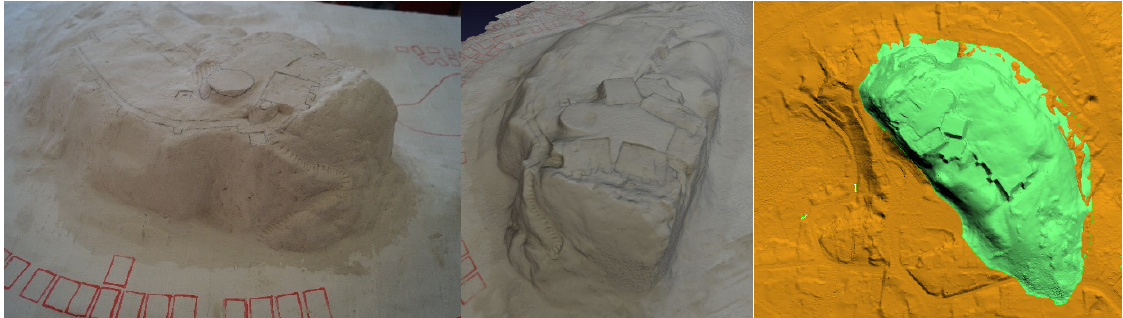
Figure 3. The historic physical 3D model of the Kalkberg (left), the historic digital 3D model from dense image matching (centre) and the combination of two DEMs from both today (orange) and the past (green)